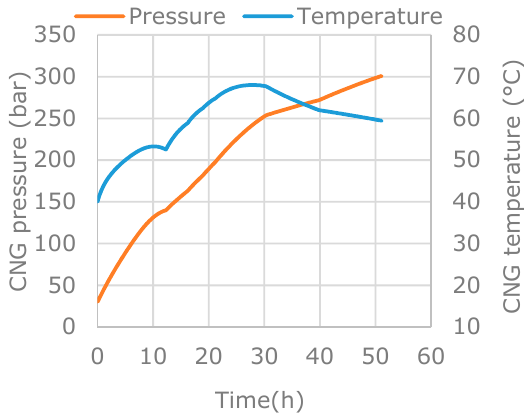
Figure 17. Pressure vessels CNG conditions (summer loading).